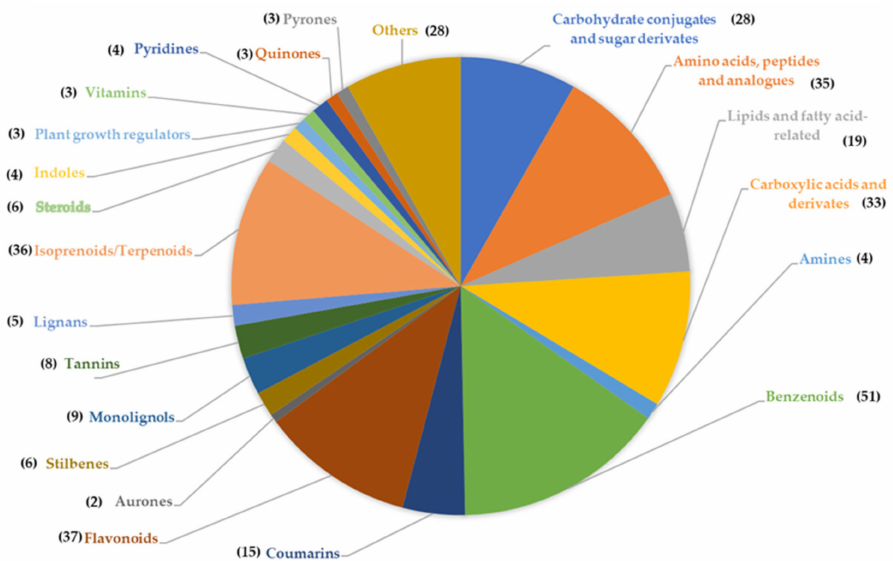
Figure 5. Pie chart of the chemical families identified in Q. ilex seedlings subjected to drought stress. The number in parentheses indicates the annotated compounds